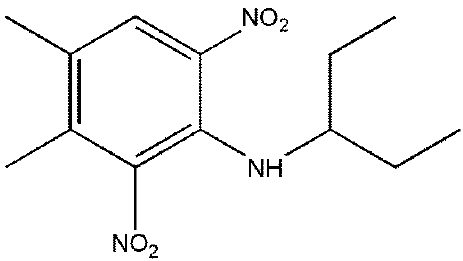
Figure 1. Pendimethalin